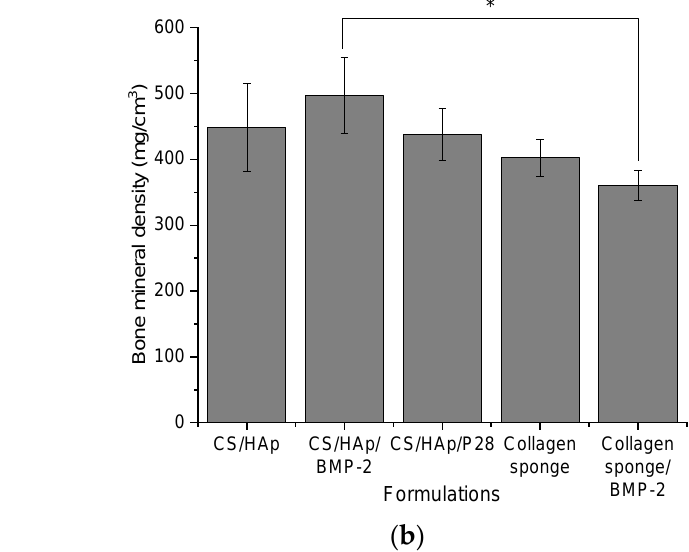
Figure 9. ( a ) Graph of mean volume fraction for each sample group in the entire defect and its margin after eight weeks (ROI 4 mm) (CS/HAp: 39 ± 9.3%; CS/HAp/BMP-2: 45.7 ± 6.6%; CS/HAp/P28: 34.1 ± 6.1%; Collagen sponge: 26.2 ± 2.3%; Collagen sponge/BMP-2: 23.2 ± 3.3%). ( b ) Graph of mean bone mineral density per sample group in the entire defect and margin after eight weeks (ROI 4 mm) (CS/HAp: 449.06 ± 66.69 mg/cm 3 ; CS/HAp/BMP-2: 497.03 ± 57.45 mg/cm 3 ; CS/HAp/P28: 438.37 ± 38.94 mg/cm 3 ; Collagen sponge: 402.6 ± 28.45 mg/cm 3 ; Collagen sponge/BMP-2: 360.83 ± 22.93 mg/cm 3 . Significant difference was achieved in CS/HAp/rhBMP-2 treatments compared to the others. However, the values might be due to traces of HAp, which is a type of ceramic. (* p <